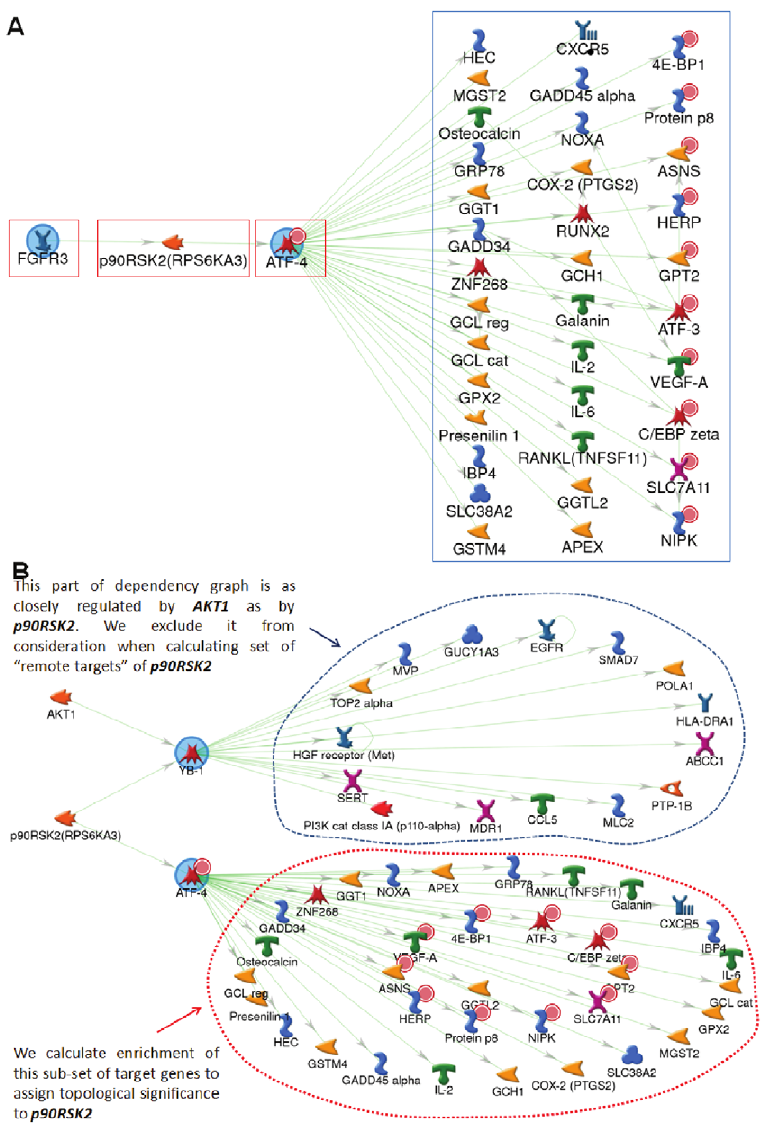
Figure 4. ‘‘Hidden’’ regulatory proteins in signaling pathways. (A) FGFR3 and p90RSK2 in this simple network are not affected on the gene expression level, therefore remaining ‘‘hidden’’ from a microarray assay. We identify sets of remote targets associated with each of the signaling molecules and assess their enrichment with differentially expressed genes. Remote targets of FGFR3 and p90RSK2 are proteins within the blue box. They could be many steps downstream of signaling proteins. Topological significance is assigned to regulatory nodes based on the enrichment of associated sets of target genes. Red boxes indicate topologically significant nodes in this network. (B) Topological scoring of regulatory nodes in complex networks with competitive regulation. (See text for details).